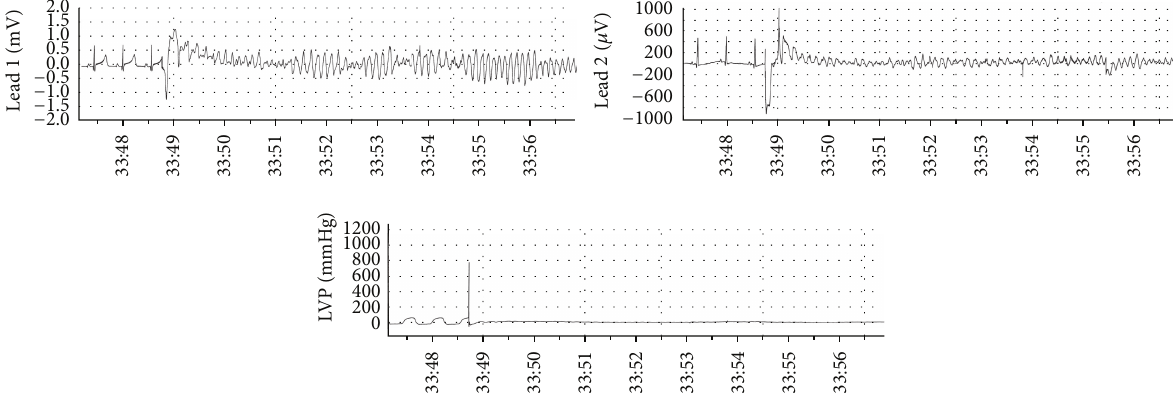
Figure 2: Initiation of ventricular fibrillation with a chest wall impact of a 40 mph lacrosse ball directly over the cardiac silhouette of an 18 kg swine. The impact occurs on the upslope of the T-wave and produces an immediate left ventricular pressure (LVP) rise to 800 mmHg and ventricular fibrillation.